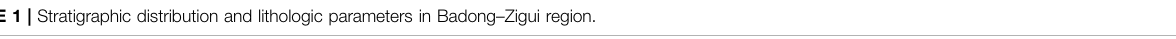
TABLE 1 | Stratigraphic distribution and lithologic parameters in Badong – Zigui region. Locations Lithology and density Western and southern of